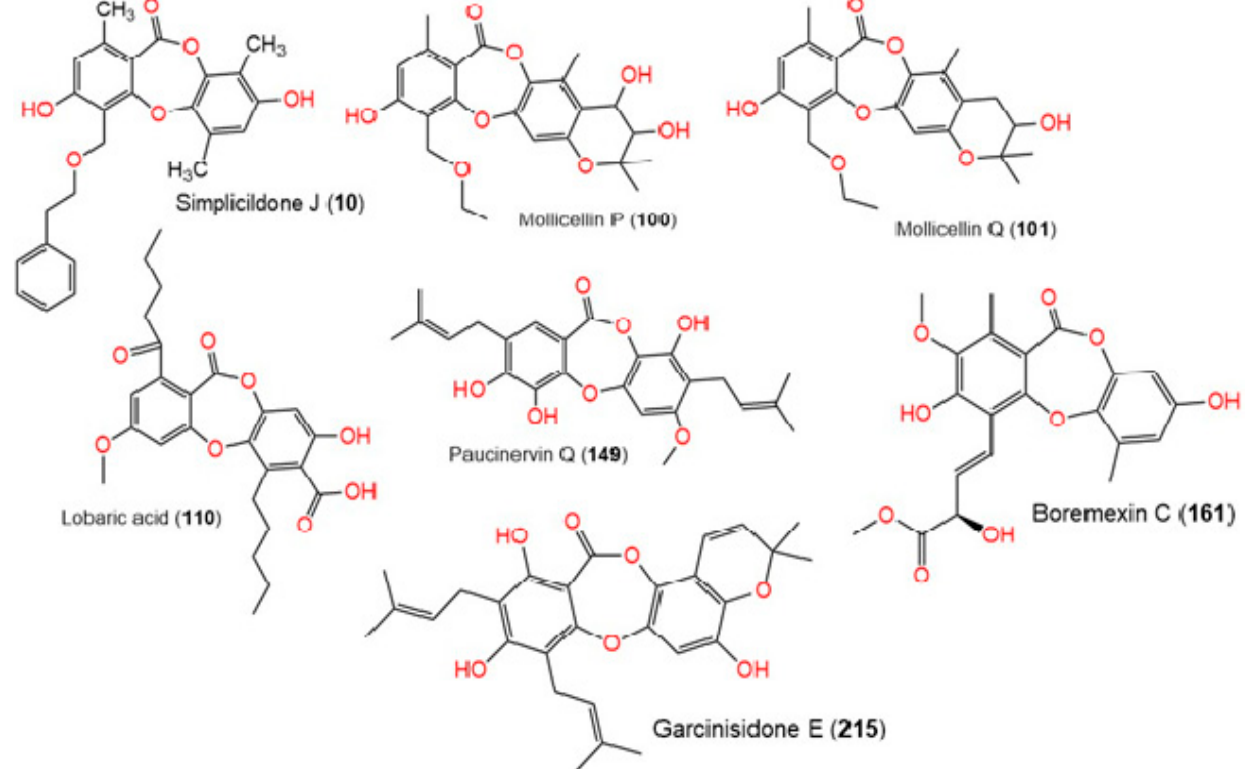
Figure 3. Chemical structure of depsidones with higher docking scores.